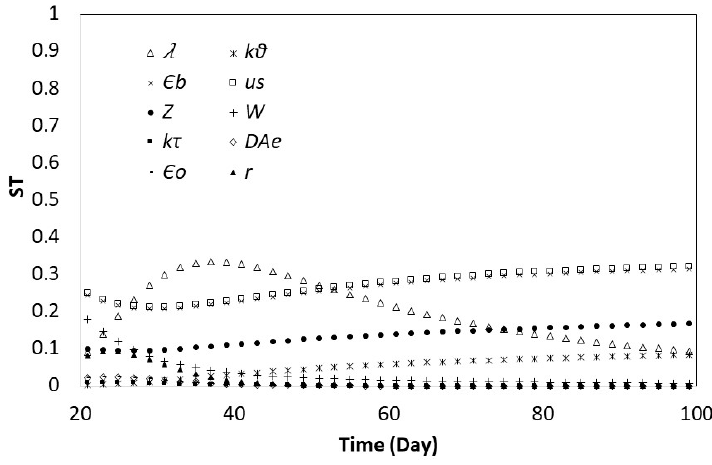
Figure 9. GSA of the model at u s 9.0 cm 3 /cm 2 · s.